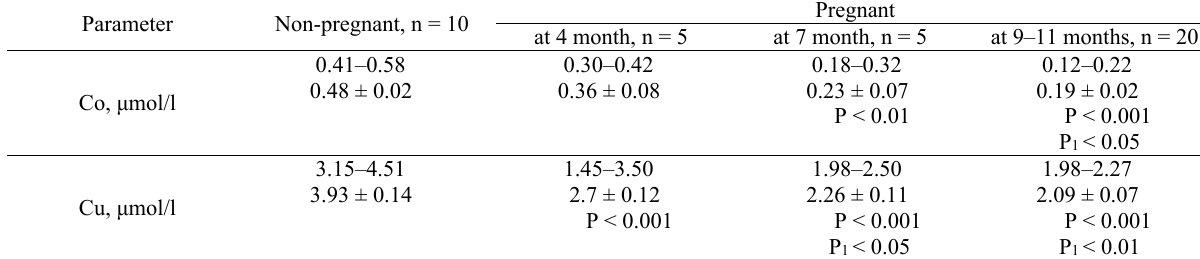
Table 2 The content of Cobalt and Copper in the blood of mares (Lim, М ± m)